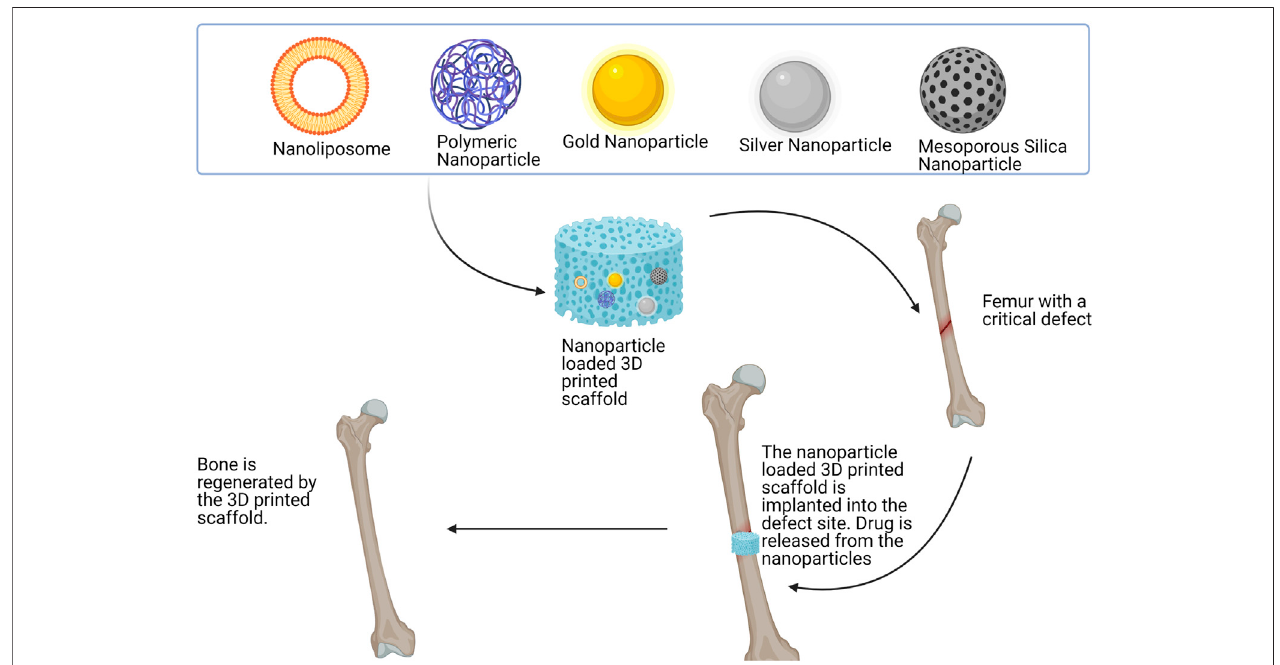
FIGURE 5 | The various types of nanocarriers that may be incorporated into a scaffold. The nanocarriers are included in a 3D printed scaffold. The scaffold is then implanted into the critical defect site present in the femur due to osteosarcoma resection. Chemotherapeutics are released from the scaffold to target residual cancer cells while the scaffold regenerates the bone. This fi gure was created with BioRender.com.